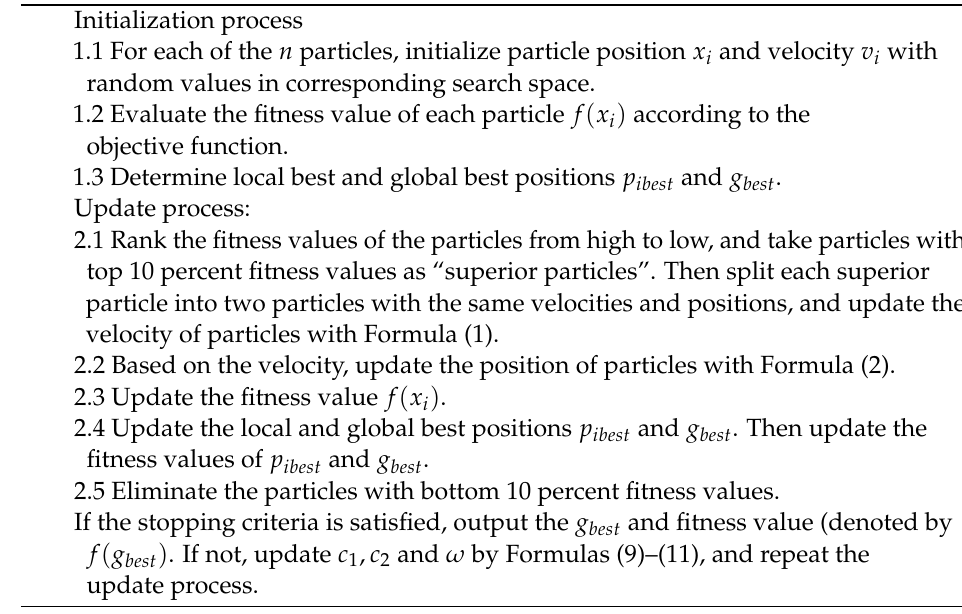
Algorithm 1: Improved PSO